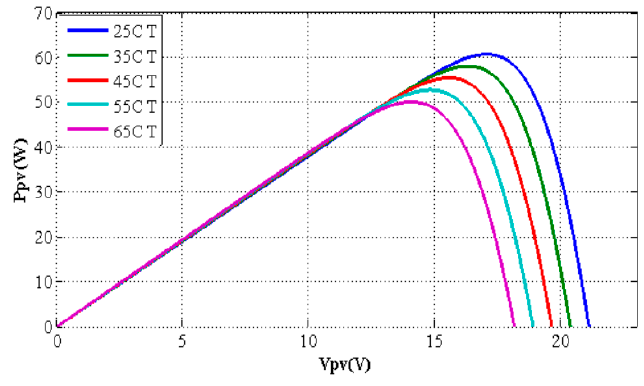
Figure 21. P vs. V Characteristics with varying temperature.